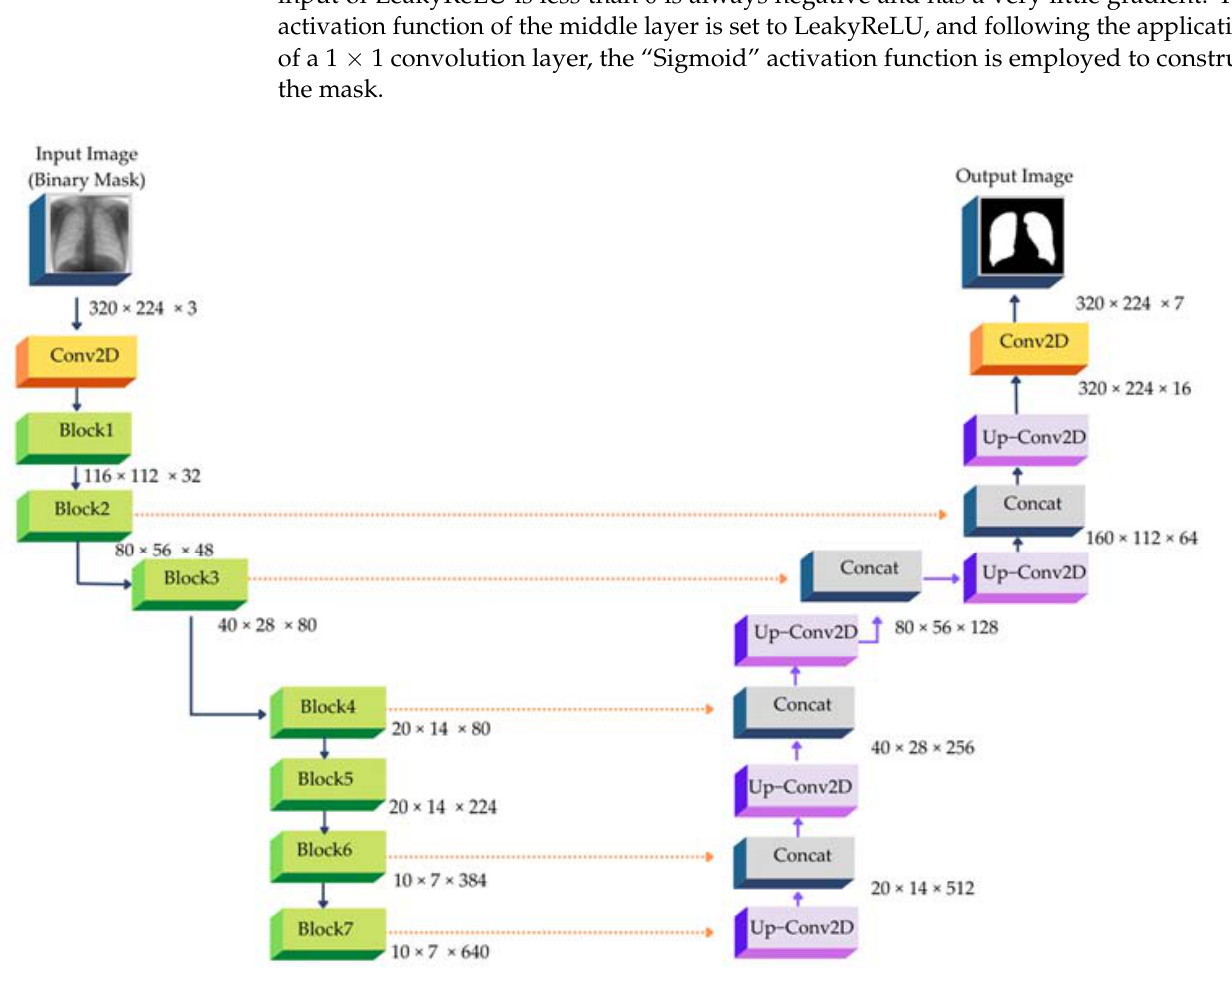
Figure 7. The architecture of U-Net with EfficientNetB7 Encoder (adapted from [63]).